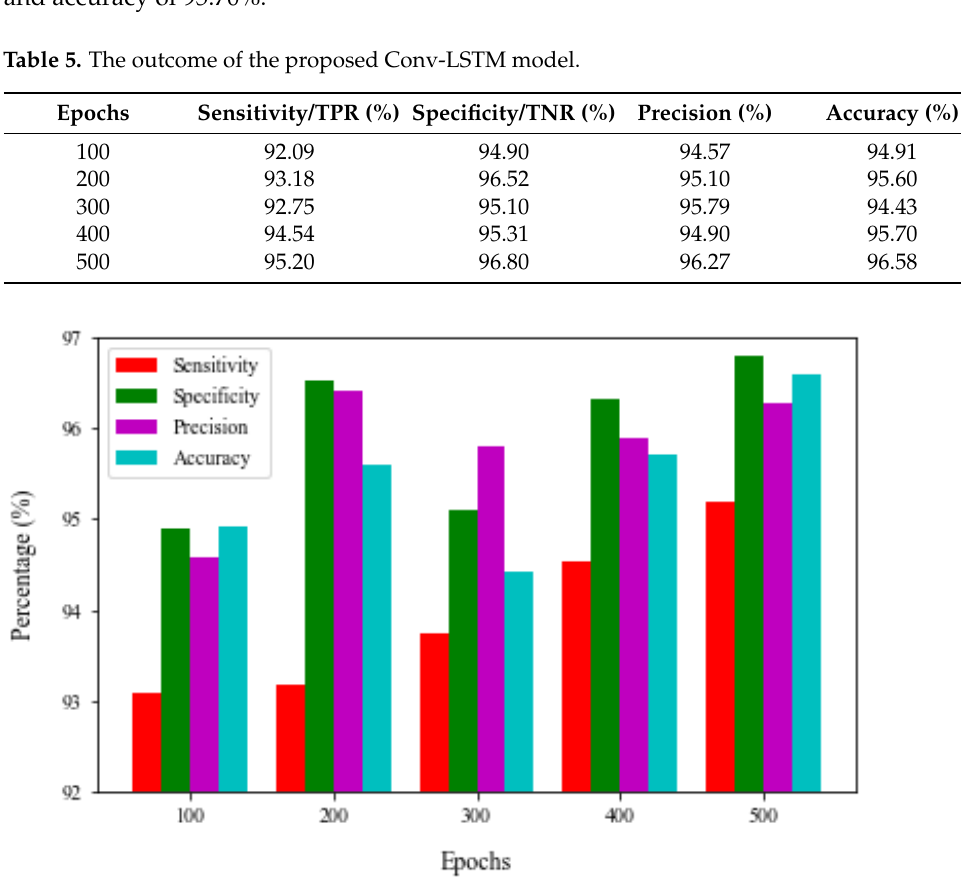
Table 6. ROC-AUC score for different